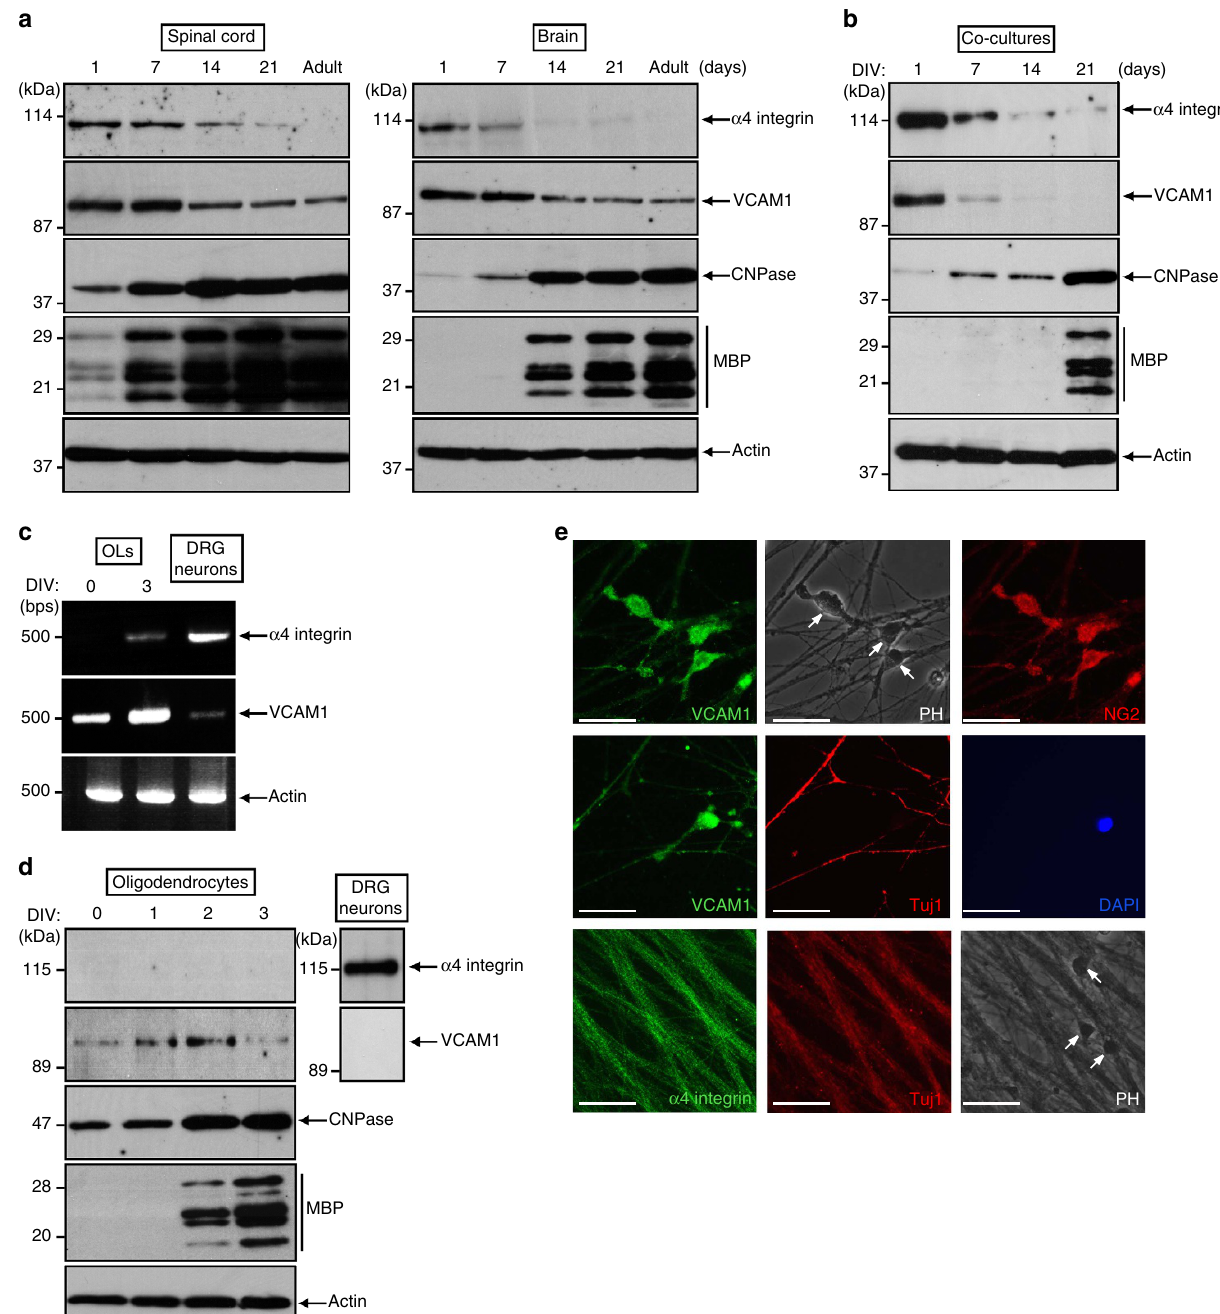
Figure 1 | Changes in expression levels of VCAM1 and a 4 integrin. ( a ) Tissue extracts were prepared from mouse spinal cords or whole brains on postnatal days 1–21 or in adulthood, subjected to SDS-polyacrylamide gel electrophoresis, transferred to a PVDF membrane and immunoblotted with an antibody against a 4 integrin, VCAM1, CNPase, MBP or control actin. Data are representative of four experiments. ( b ) Rat oligodendrocytes and DRG neurons were co-cultured for 1–21 DIV, lysed and used for the respective immunoblottings. Data are representative of three experiments. ( c ) RT-PCR analysis was performed for a 4 integrin, VCAM1 or control actin in differentiating oligodendrocytes (OLs) or neurons. Data are representative of two experiments. ( d ) Oligodendrocytes or neurons were lysed and used for immunoblottings. Data are representative of three experiments. ( e ) DIV2 co-cultures were co-stained with antibodies against VCAM1 (green) and NG2 (red; top row), VCAM1 (green), Tuj1 (red) and DAPI (middle row), or a 4 integrin (green) and Tuj1 (red) (bottom row). PH, phase-contrast microscopy. Arrows indicate oligodendrocyte cell bodies. Data are representative of three experiments. Scale bar, 50 m Olig2 þ cells can be due to an increase in oligodendrocyte proliferating Olig2-positive (Ki67 þ /Olig2 þ ) cells (Fig. 2c,d, and Supplementary Fig. 3a,b). The number of proliferating, precursor cells. In 21-day-old mice, Olig2-positive cell numbers NG2-positive (Ki67 þ /NG2 þ ) cells in VCAM1 cKO mice was and the percentage of proliferating cells were comparable in control and VCAM1 cKO mice (Supplementary Fig. 3a,b). also increased (Fig. 2e), suggesting that an increase in Ki67 þ /